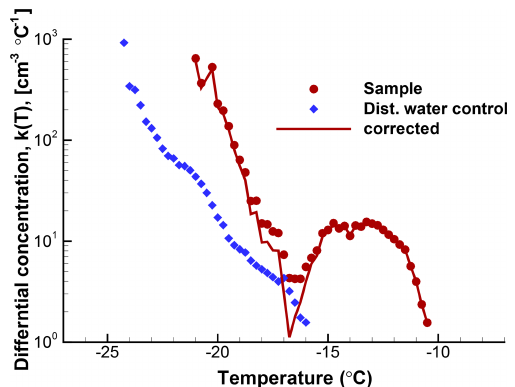
Figure 6. Differential spectra for the same data as shown in Fig. 5. Circle symbols are for the soil sample; diamond symbols are for the control (blue). The spectrum for the soil sample after correction for the distilled water background is shown with a line. The magni- tude of the correction is relatively minor in this case except in the temperature region between about − 14 and − 18 ◦